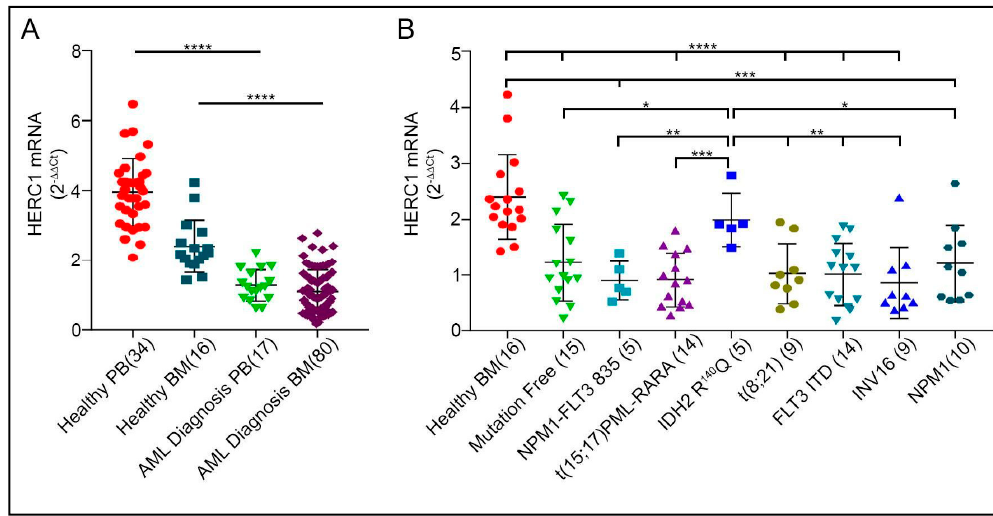
Figure 2. The HERC1 transcript is severely downmodulated in acute myeloid leukemia independently from genetic alteration. ( A ) HERC1 level is significantly downregulated in both PB ( n = 17) and BM ( n = 80) specimens derived from AML at diagnosis. ( B ) The stratification of the AML samples according to the different cytogenetic categories and to the most common genetic variants displayed that the HERC1 transcript downregulation is a common feature shared by almost all the different groups with the exception of the IDH2 mutated cohort, in which its gene expression is comparable to that of the controls. * p < 0.05, ** p < 0.01, *** p < 0.001, **** p < 0.0001.